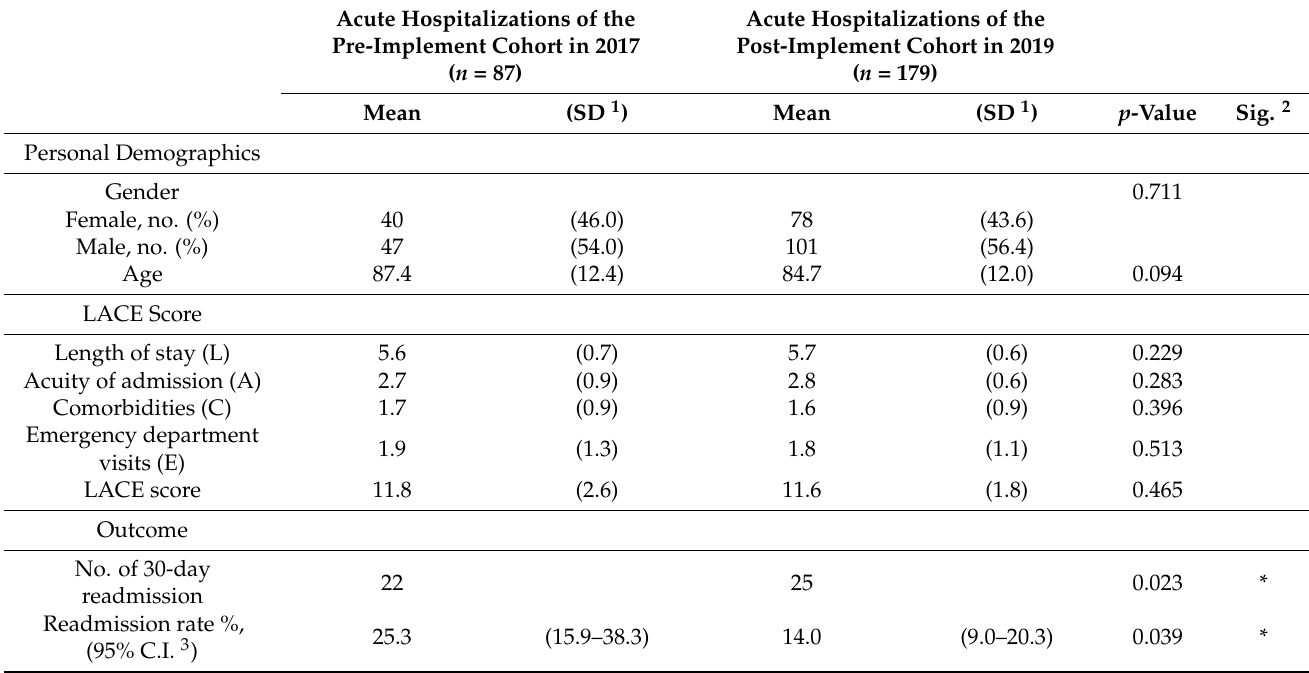
Table 1. Demographic information, LACE score, and outcome before (Pre-Implement) and after (Post-Implement) implement- ing LACE score-based predictive risk management tool to long-term home care (LTHC) patients a medical center affiliated home care unit in Taiwan in 2017 and 2019. (Pre-Implement cohort in 2017, n = 87; Post-Implement cohort in 2019, n = 179). Acute Hospitalizations of the Pre-Implement Cohort in